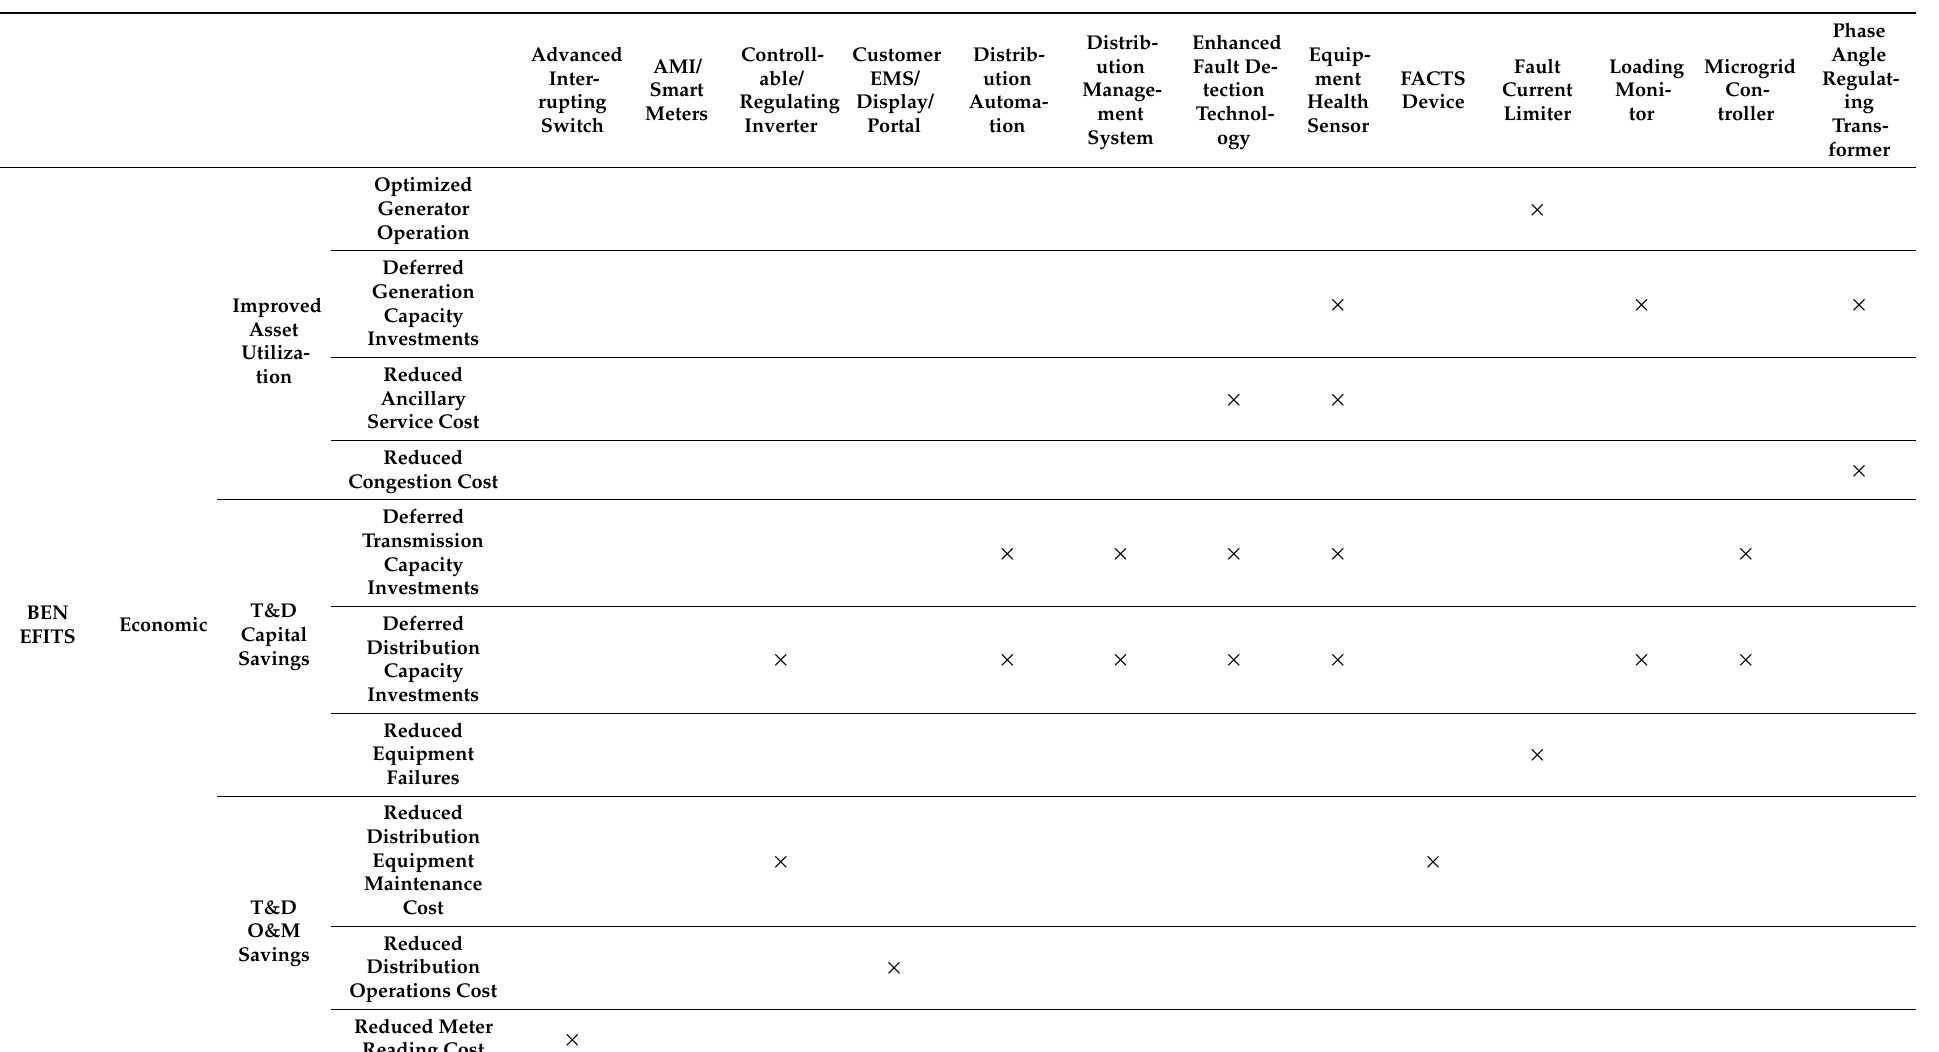
Table 1. Smart grid assets and